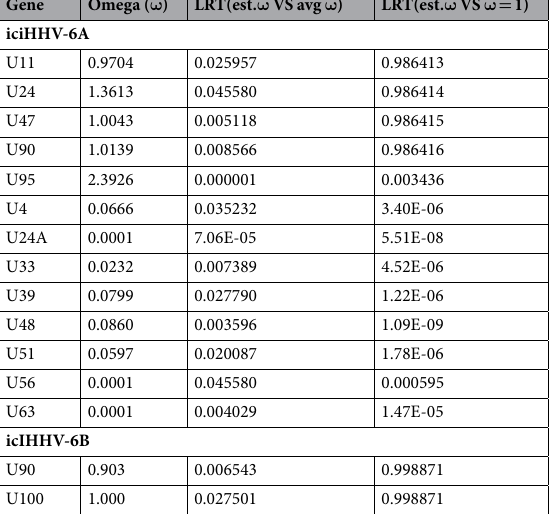
Table 2. Genes showing strong selection footprint. Genes with estimated ω significantly different from the average value of the species is shown. The LRT results between a model that estimates ω for each branch of the tree and the same model with ω fixed at the average value of the species, and fixed at 1, are